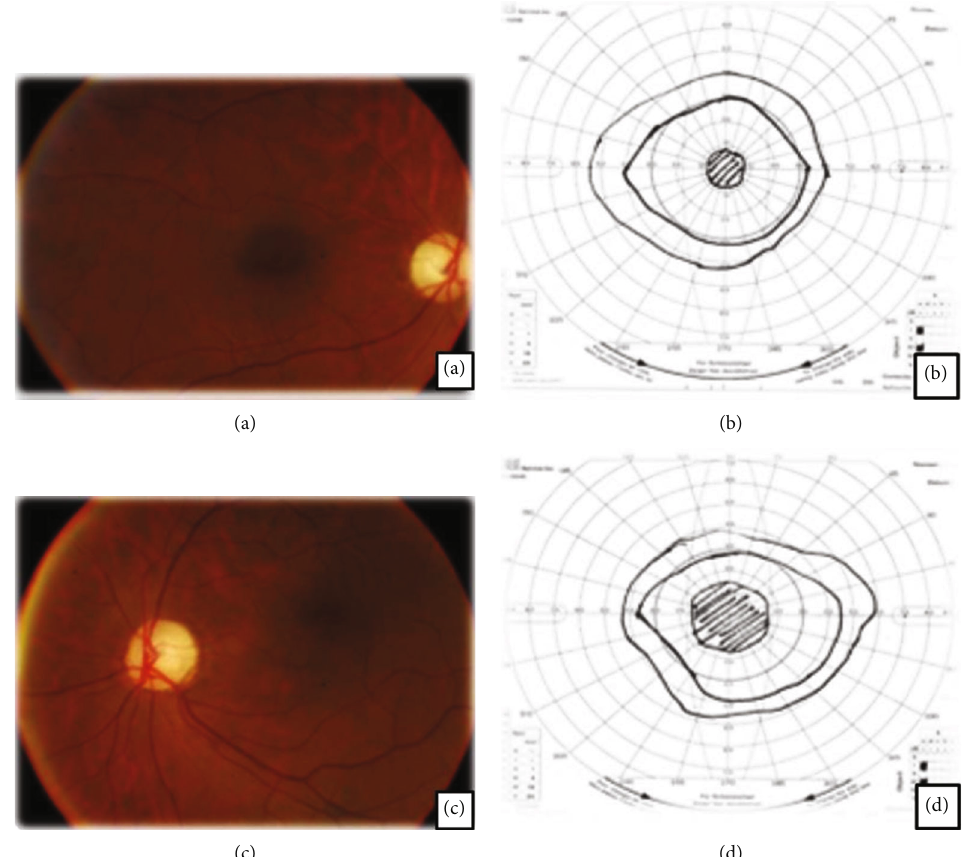
Figure 1: Retinography (a, c) showing optic disc pallor and arteriolar attenuation. The Goldmann visual fi eld (b, d) showed bilateral constriction and central